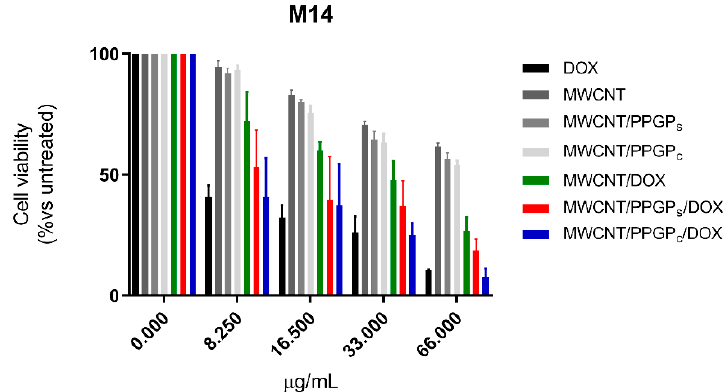
Figure 13. Cell viability (MTT assay) of M14 human lung adenocarcinoma cells untreated and treated for 48 h with different concentrations of free DOX hydrochloride or into both unloaded and loaded CNT. Each point represents mean ±s.e.m. of three separate experiments performed in triplicate.